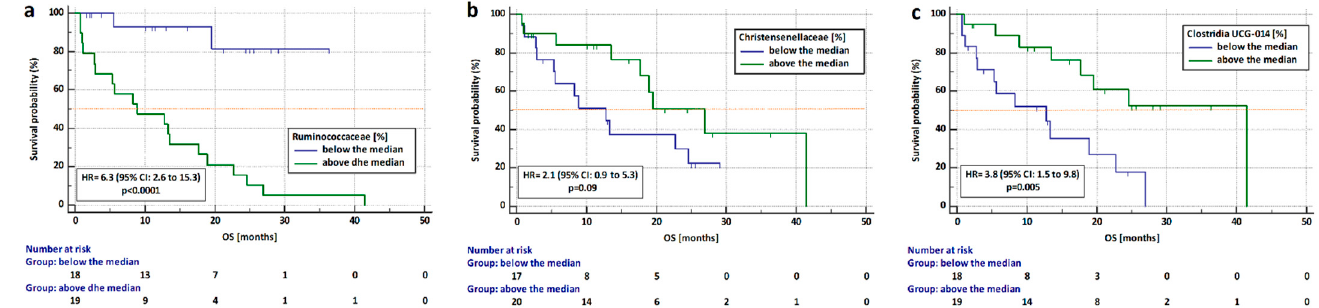
Figure 9. Analysis of overall survival in patients who received Immunotherapy depending on the content of ( a ) Ruminococcaceae ), ( b ) Christensenalceae , and ( c ) Clostridia UCG-014 regardless of immunotherapy line in the group untreated with antibiotics up to 4 weeks before immunotherapy. Table 1. Effect of an abundance of selected bacteria in gut microbiome on the risk of death and progression in patients undergoing immunotherapy in Cox multivariate analysis.